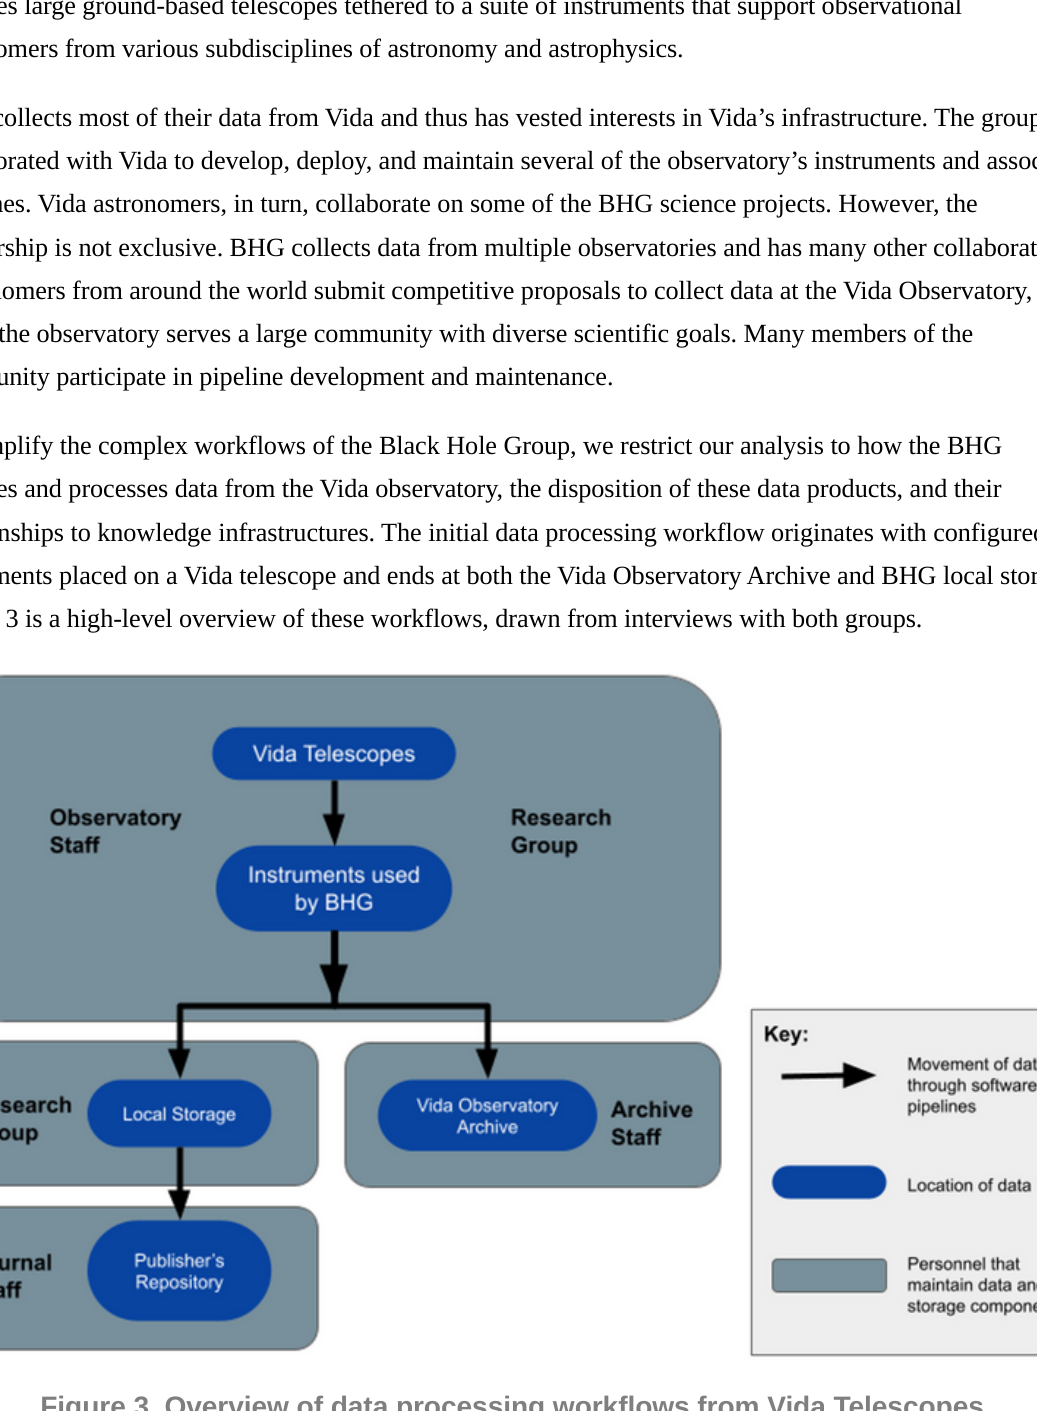
Figure 3. Overview of data processing workflows from Vida